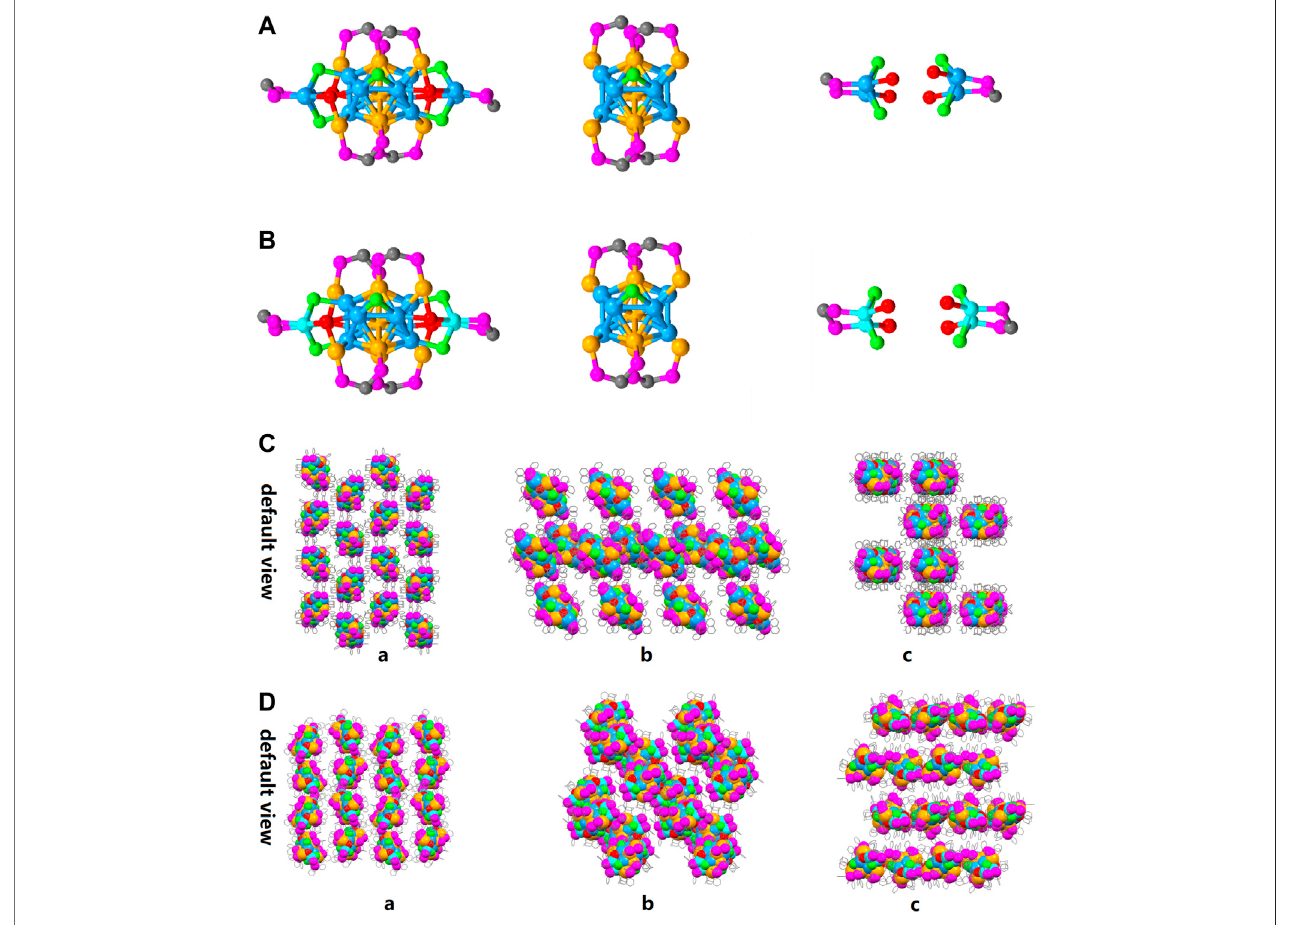
FIGURE3|(A) theoverallstructureof[Au 9 Ag 12 (SAdm) 4 (Dppm) 6 Cl 6 ](SbF 6 ) 3 ; (B) theoverallstructureof[Au 9 Ag 8 Cu 4 (SAdm) 4 (Dppm) 6 Cl 6 ](SbF 6 ) 3 ;Packingmodelsof (C) [Au